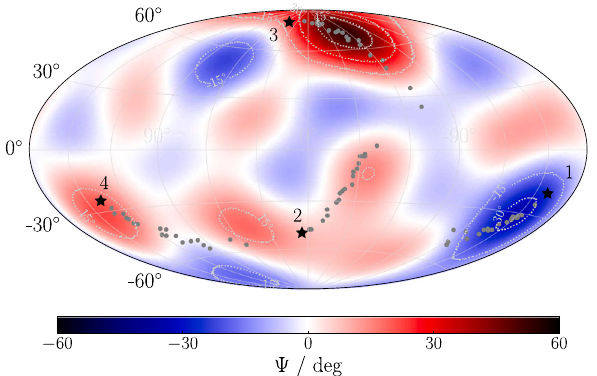
Fig. 7 Visualization of the modification angles Ψ(ϑ,ϕ) (color-coded) which is defined relative to the JF12 model ( JF12 GMF initialization for ˆ u 0 ) after a fit to benchmark 1 scenario with N s = 20 source events. Gray circles denote cosmic rays that originate from one of the four sources and the dotted lines mark contours of 15 ◦ -spacing in Ψ